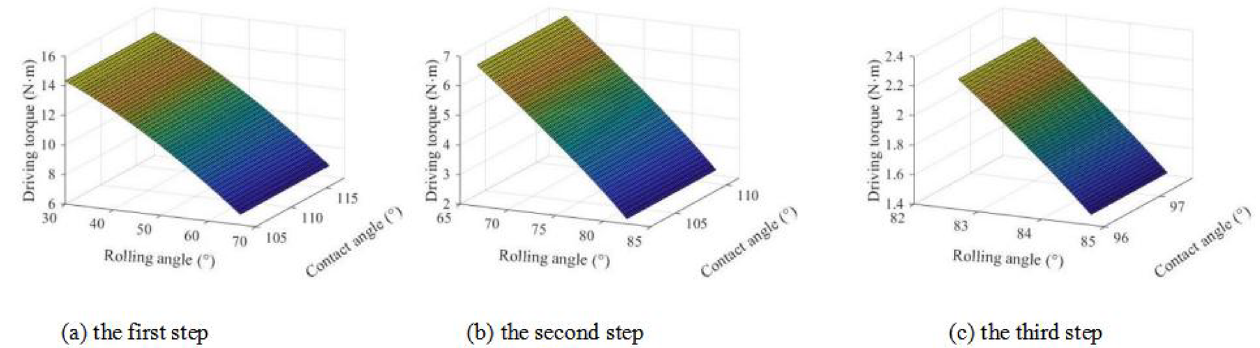
Figure 14. The variation of the torque with rolling angle and contact angle.